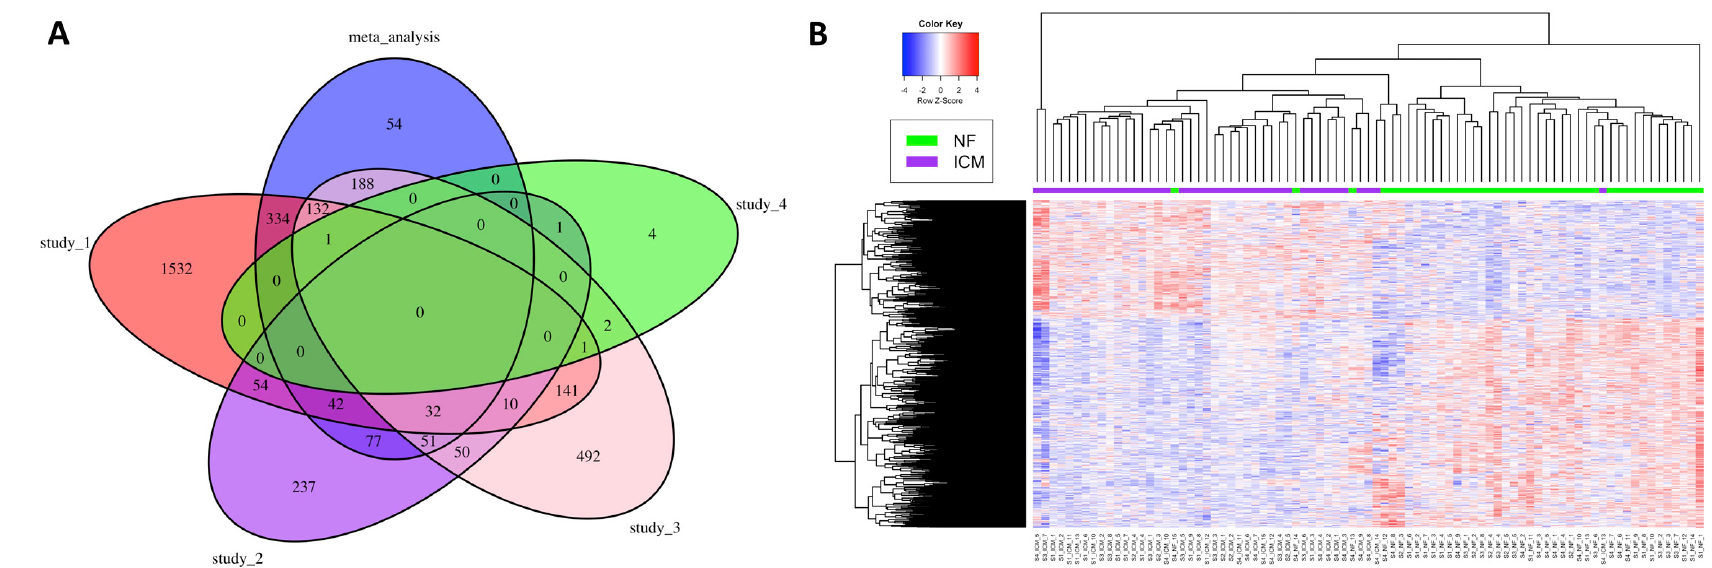
Figure 1. Venn diagram and heatmap summarizing meta-analysis identified DEGs. ( A ) Venn diagram summarizing common DEGs among the meta-analysis and the individual studies. ( B ) Heatmap of the DEGs identified by the meta-analysis. S1, S2, S3, S4: Study_1, Study_2, Study_3, Study_4 (Table 1). Table 3. DEGs identified only by meta-analysis.